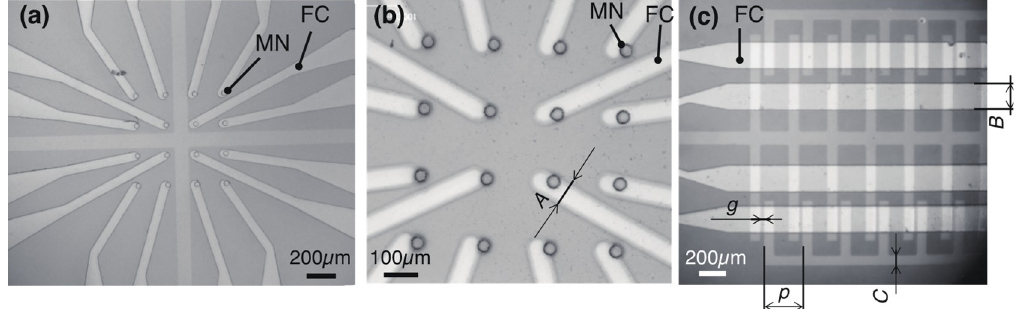
Figure 4. Micrographs of micro-nozzles integrated with ITO micropumps. ( a ) 4 × 4 micro-nozzles connected with micro-channels. Nozzle and channel were fabricated in the transparent materials PDMS and glass, which enabled observation of any transmission. ( b ) Close-up view of a micro-nozzle array. ( c ) Four series of flow channels and electrodes. FC and MN denote flow channel and a micro-nozzle, respectively. Typical dimensions were measured from five points: Nozzle diameter 34.8 µm. Channel width, A = 62.0 µ m. B = 189.1 µ m. Height, H = 71.9 µ m. Electrode width, C = 71.9 µ m. Gap g = 27.8 µ m. Pitch p = 278.8 µ